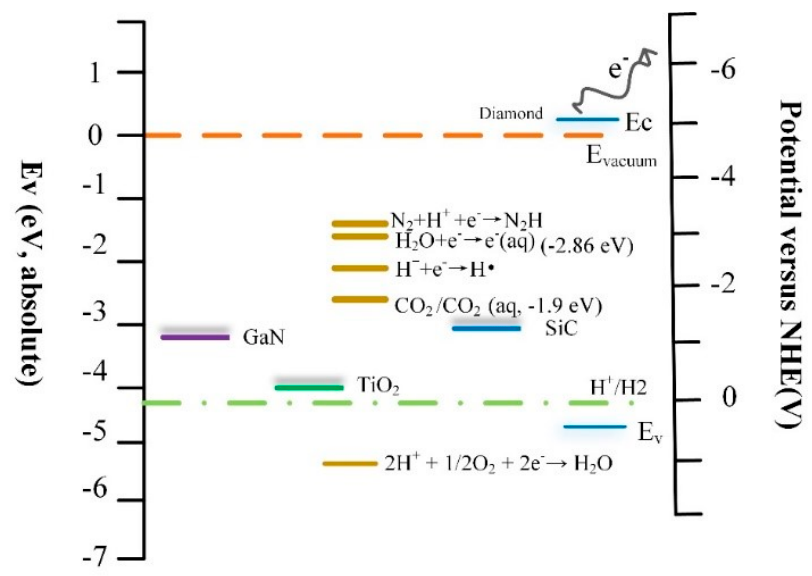
Figure 8. Electrochemical energy scale relative to the NHE of the diamond and other band wide gap semiconductors. Energy scale (left) and the electrochemical energy scale (right) relative to the NHE. Potential for reduction of oxygen to water is shown for pH 7.